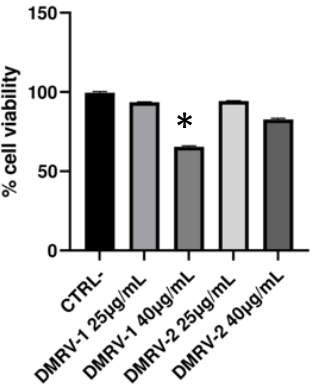
Figure 3. HUVECs viability measured by MTT assay (Mean ± SEM of 6 independent measurements) following different treatments with the two herbal preparations. The cell viability percentage of HUVECs measured after 24 h of incubation with two different concentrations (25 mg/mL and 40 mg/mL) of DMRV-1 (diosmetin 6%, magnolol 10%, V. vinifera seeds extract 48%, R. aculeatus root extract 36%) and DMRV-2 (diosmetin 11%, magnolol 9%, V. vinifera seeds extract 45%, R. aculeatus root extract 35%) is shown. CTRL-represents the negative control, consisting of HUVECs incubated with the cell medium for 24 h. * p < 0.05 vs. CTRL-.